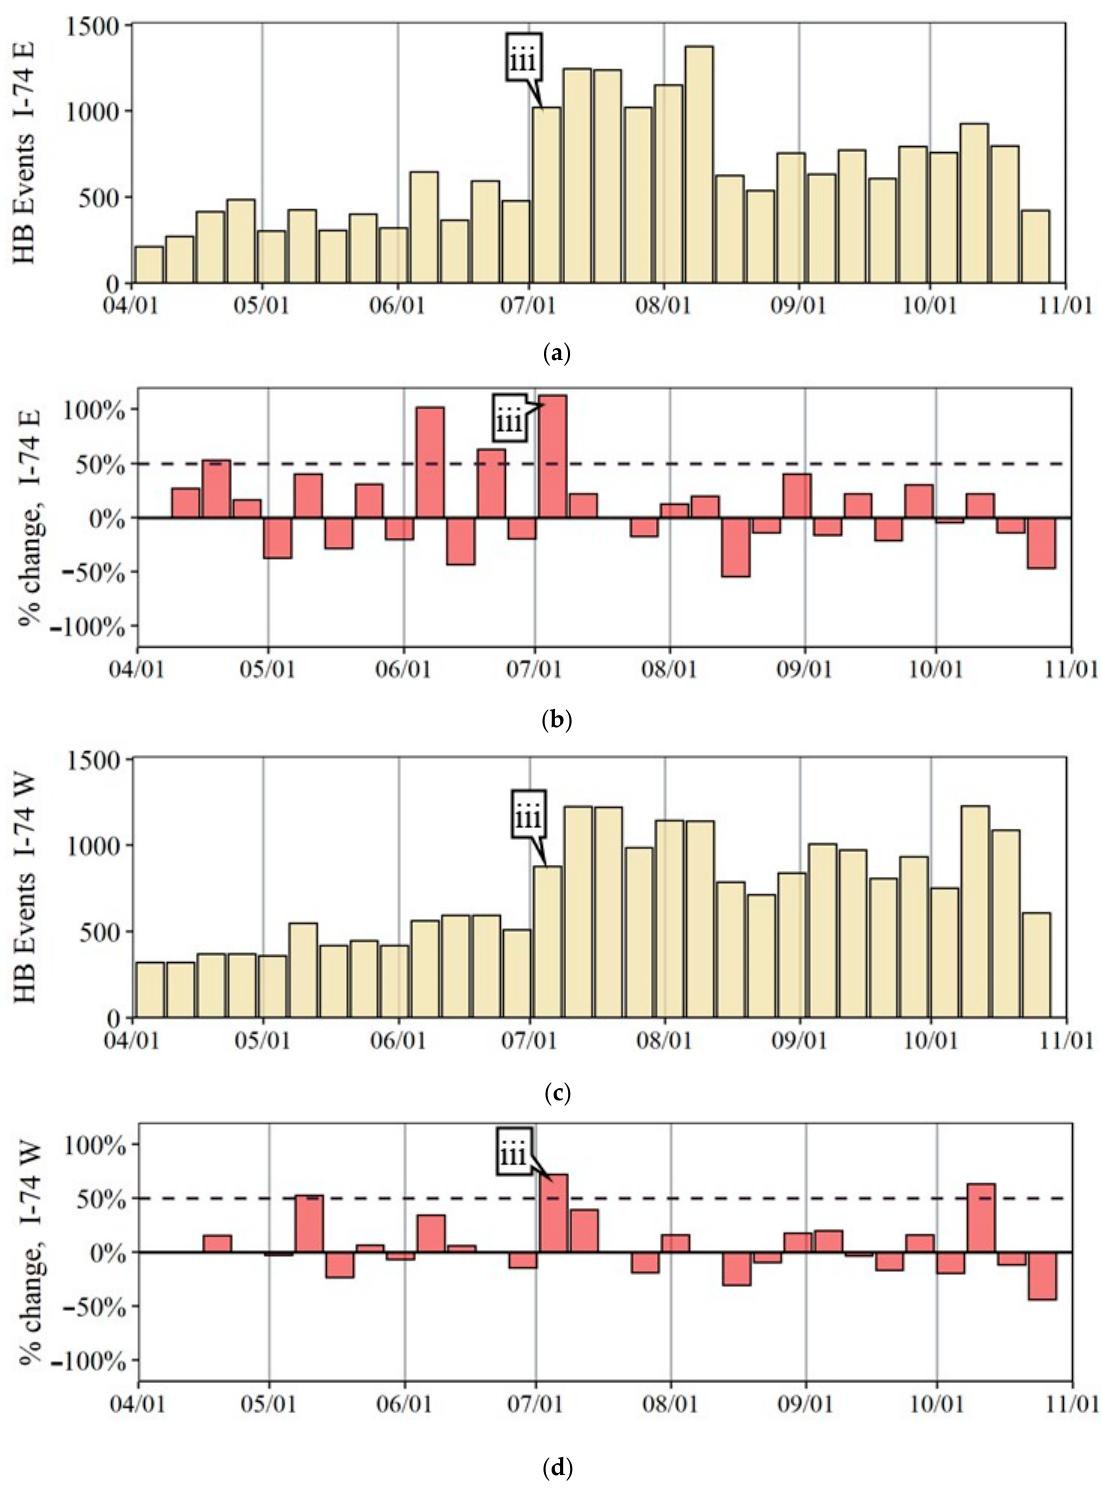
Figure 10. Comparison of hard-braking events across I-74. ( a ) Weekly hard-braking events (east- bound); ( b ) Percentage change in hard-braking events from previous week (eastbound); ( c ) Weekly hard-braking events (westbound); ( d ) Percentage change in hard-braking events from previous week (westbound).